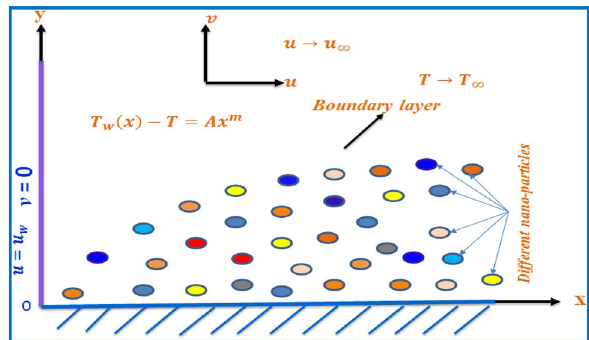
Figure 1. Sketch of the physical flow